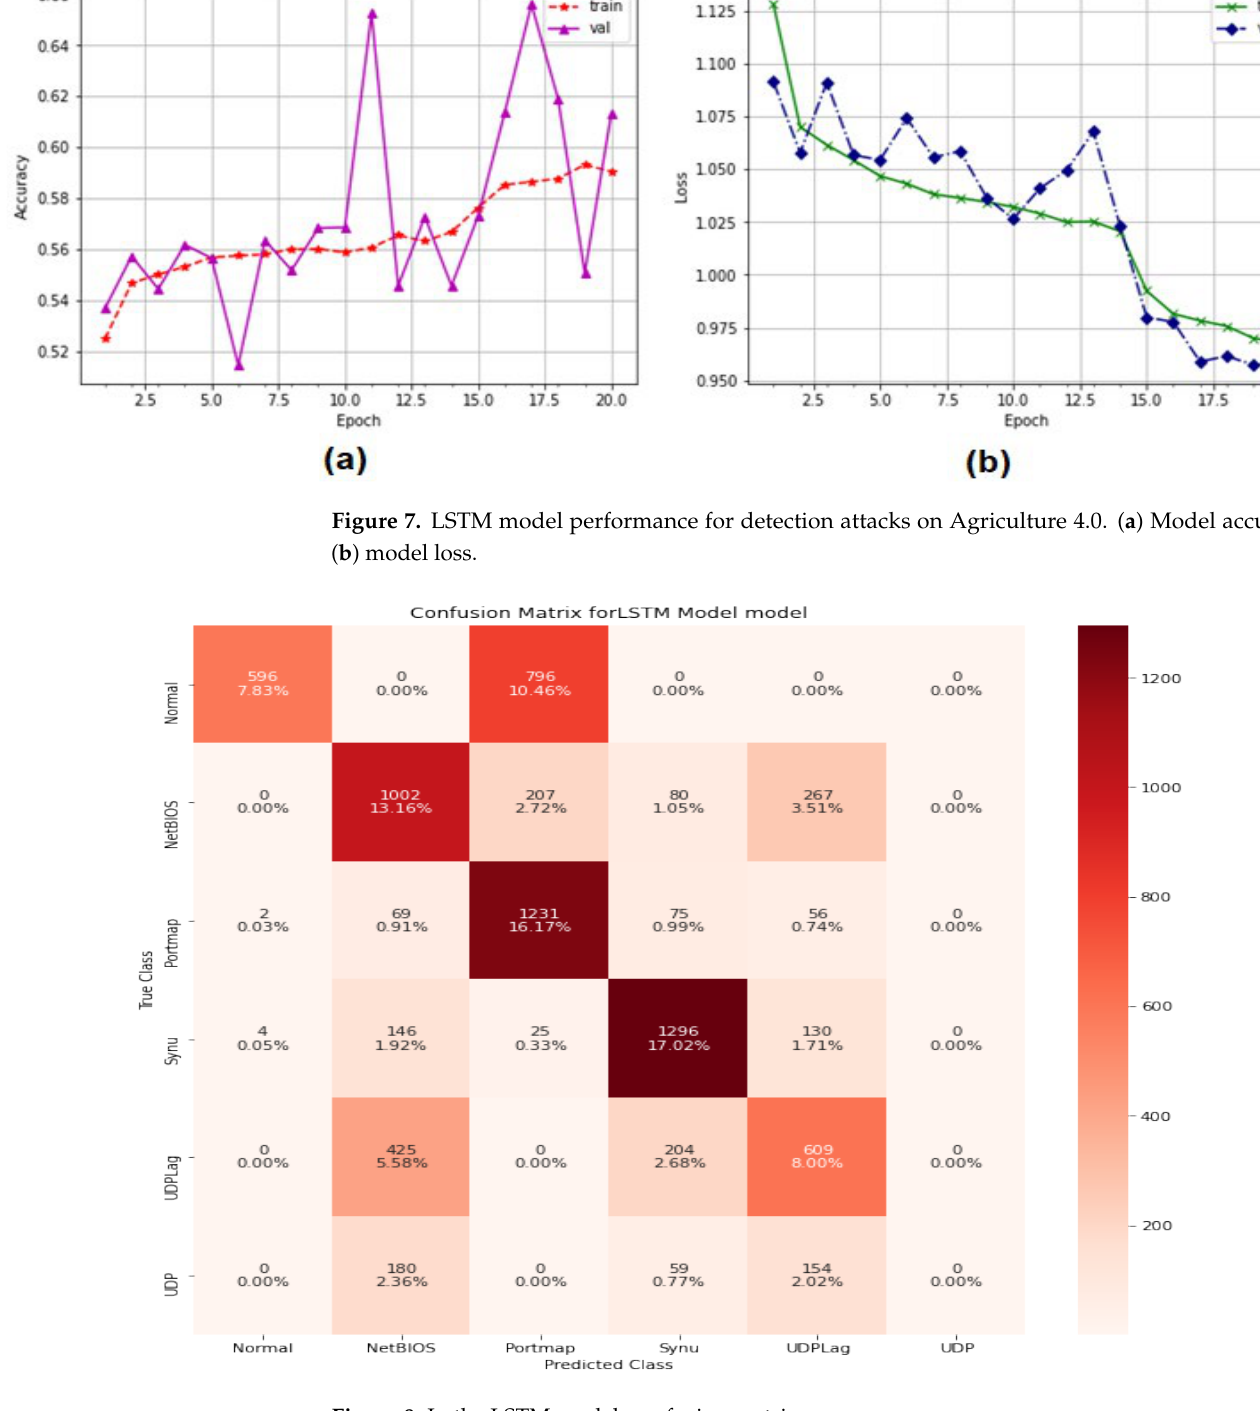
Table 5. Results of CNN–LSTM for detecting multi-classes.